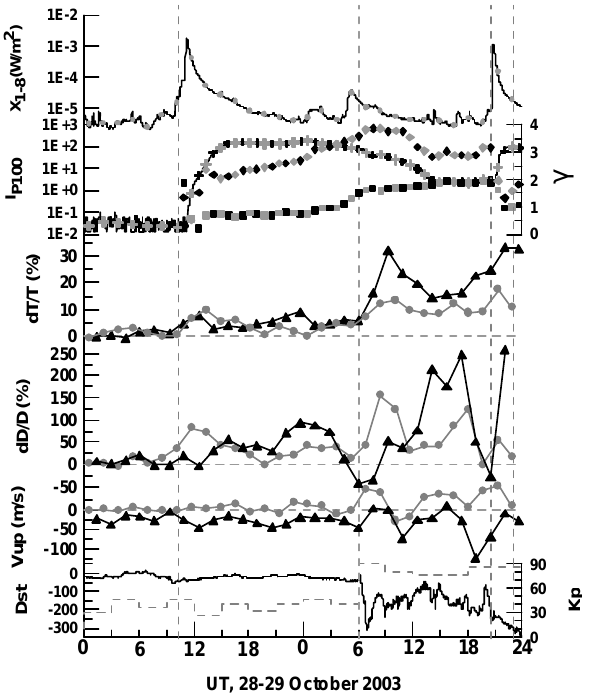
Fig. 6. The same as in Fig. 5 but for the Halloween event on 28–29 October, 2003. Vertical dashed lines depict solar flares at Figure 6. The same as in Figure 5 but for the Halloween event on October 28-29, 2003. 10:05 UT, on 28 October and at ∼ 21:30 UT, on 29 October, and Vertical dashed lines depict solar flares at 1005 UT 28 October and at ~2130 UT 29 October, the geomagnetic storm sudden commencement at ∼ 06:10 UT, on 29 October. and geomagnetic storm sudden commencement at ~0610 UT 29 October.